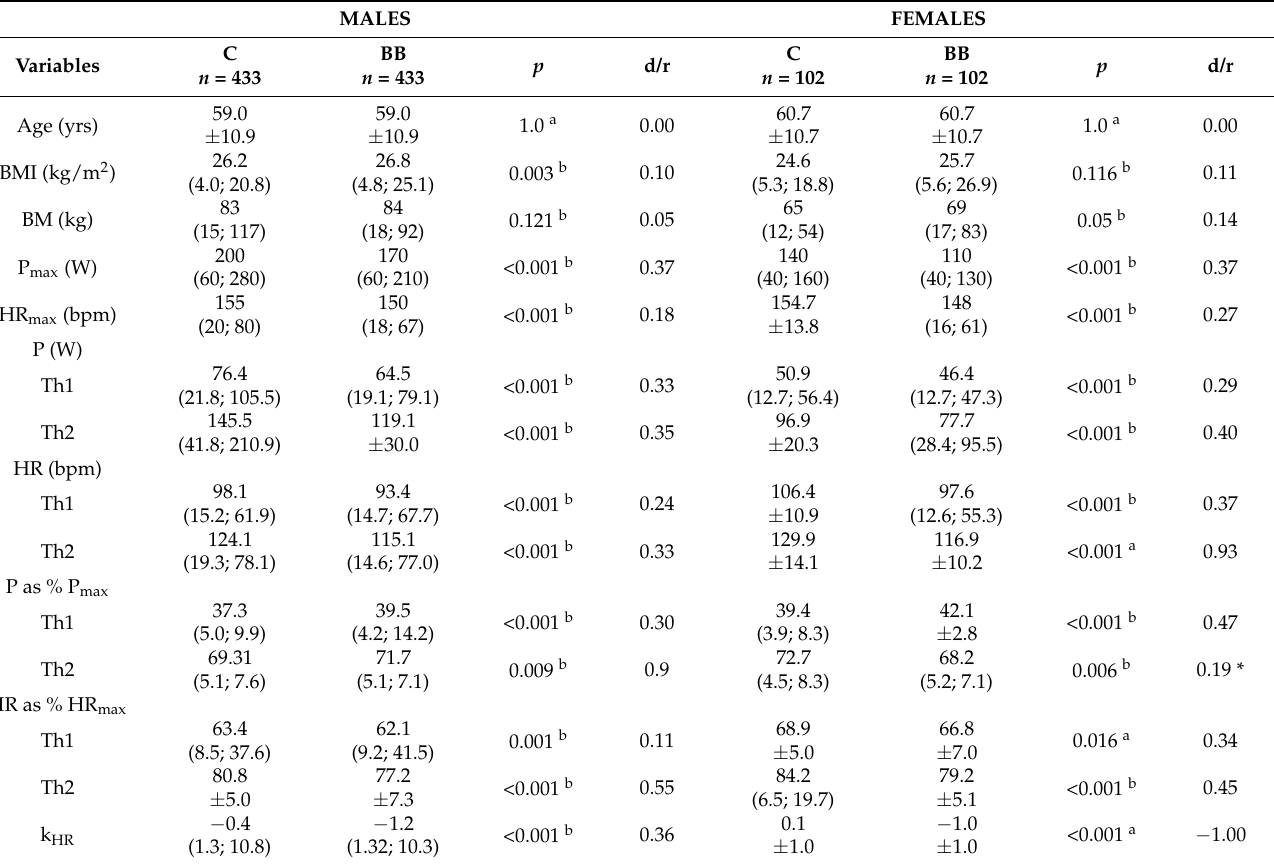
Table 1. Anthropometrics and characteristics of the incremental cycle ergometer tests in male and female individuals with (BB) and without (C) β -blocker